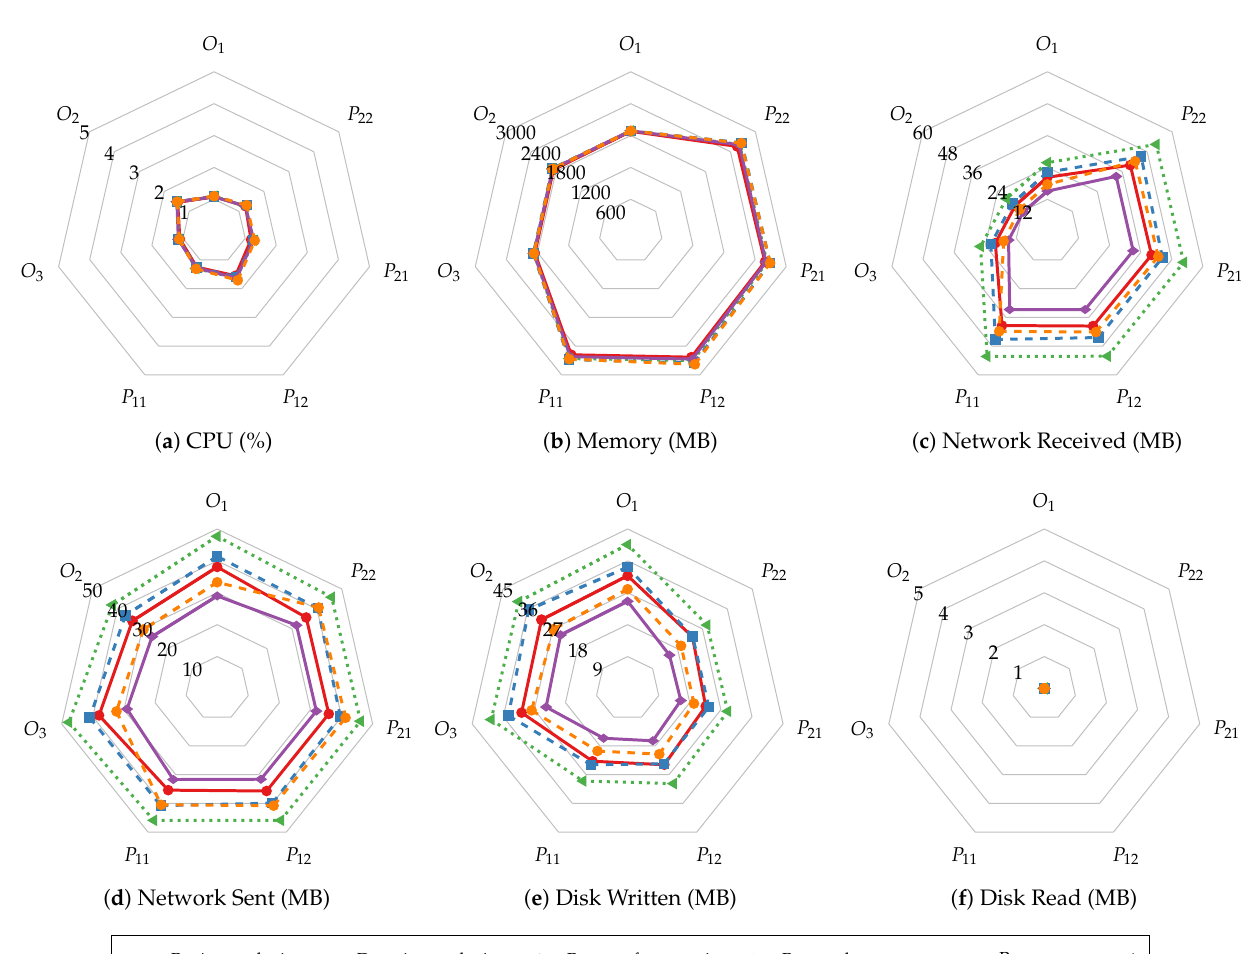
Figure 12. The average CPU usage ( a ), average memory usage ( b ), total data received from the network ( c ) and sent to the network ( d ), total data written to disk ( e ) and read from disk ( f ) of orderer1 ( O 1 ), orderer2 ( O 2 ), orderer3 ( O 3 ), org1 peer1 ( P 11 ), org1 peer2 ( P 12 ), org2 peer1 ( P 21 ), and org2 peer2 ( P 22 ) during transaction operations when S soft = 2 MB.